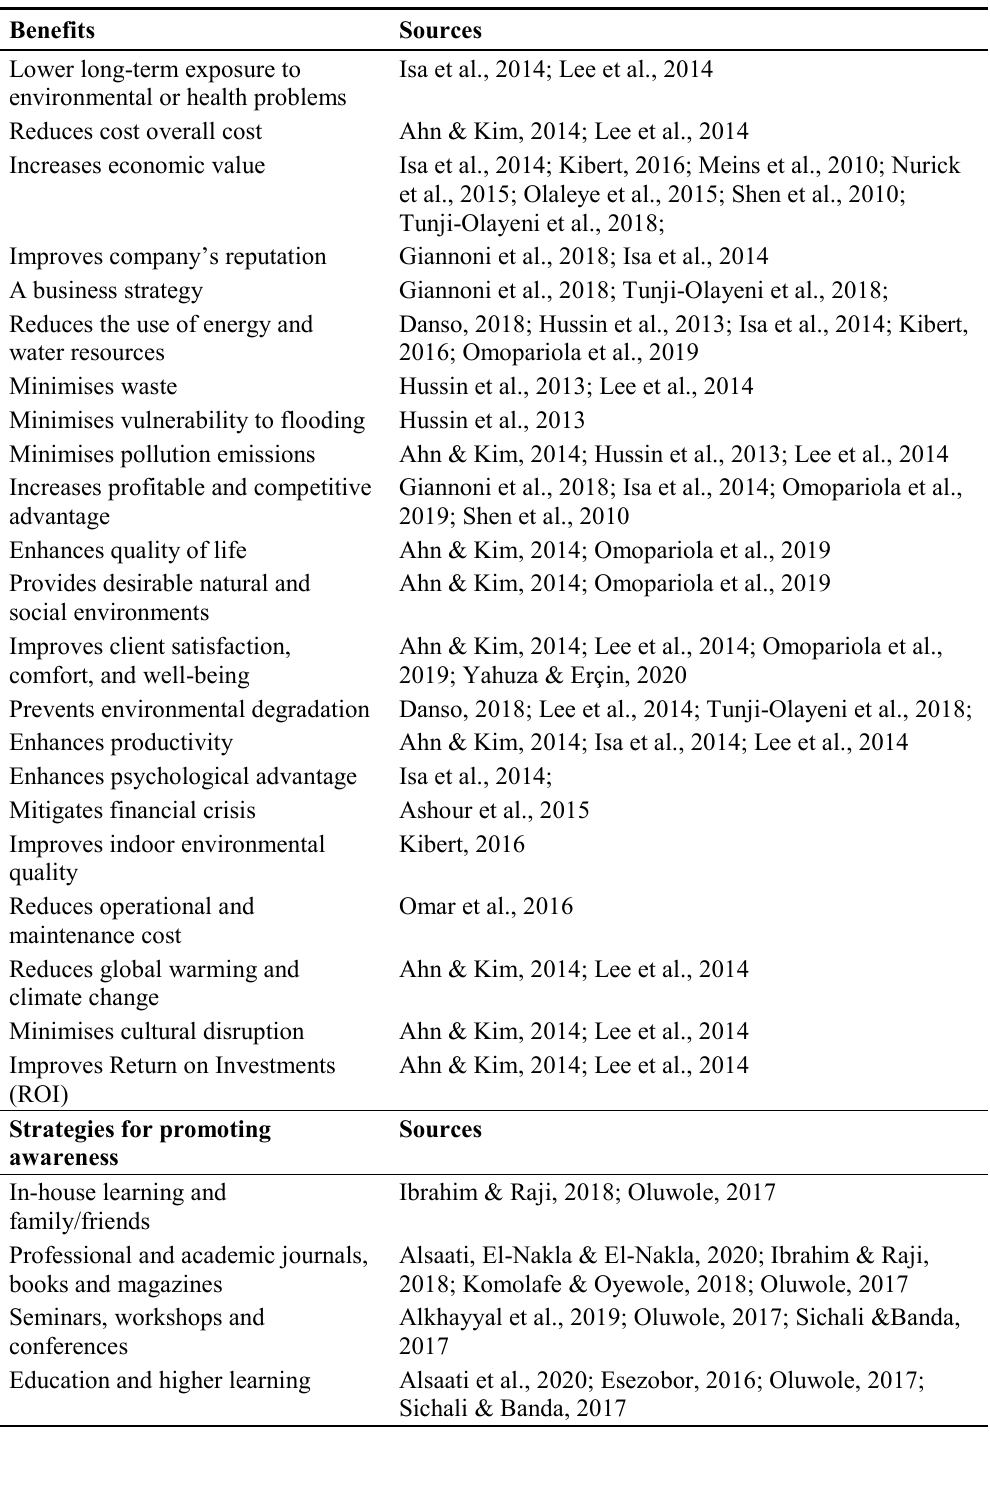
Table 1. Benefits and Strategies for Optimising Awareness of Sustainable Construction